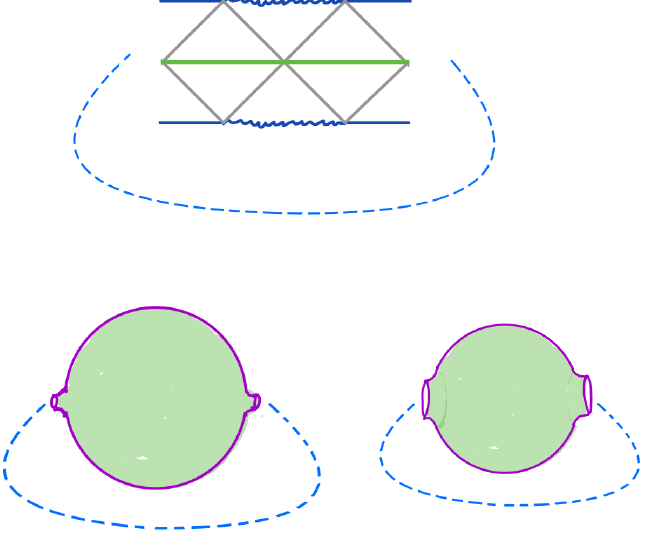
Figure 13. De Sitter-Schwarzschild black hole. The upper panel shows the Penrose diagram and the two lower panels show the spatial geometry of time-symmetric slices. In each case, the dashed blue curves indicate geometric